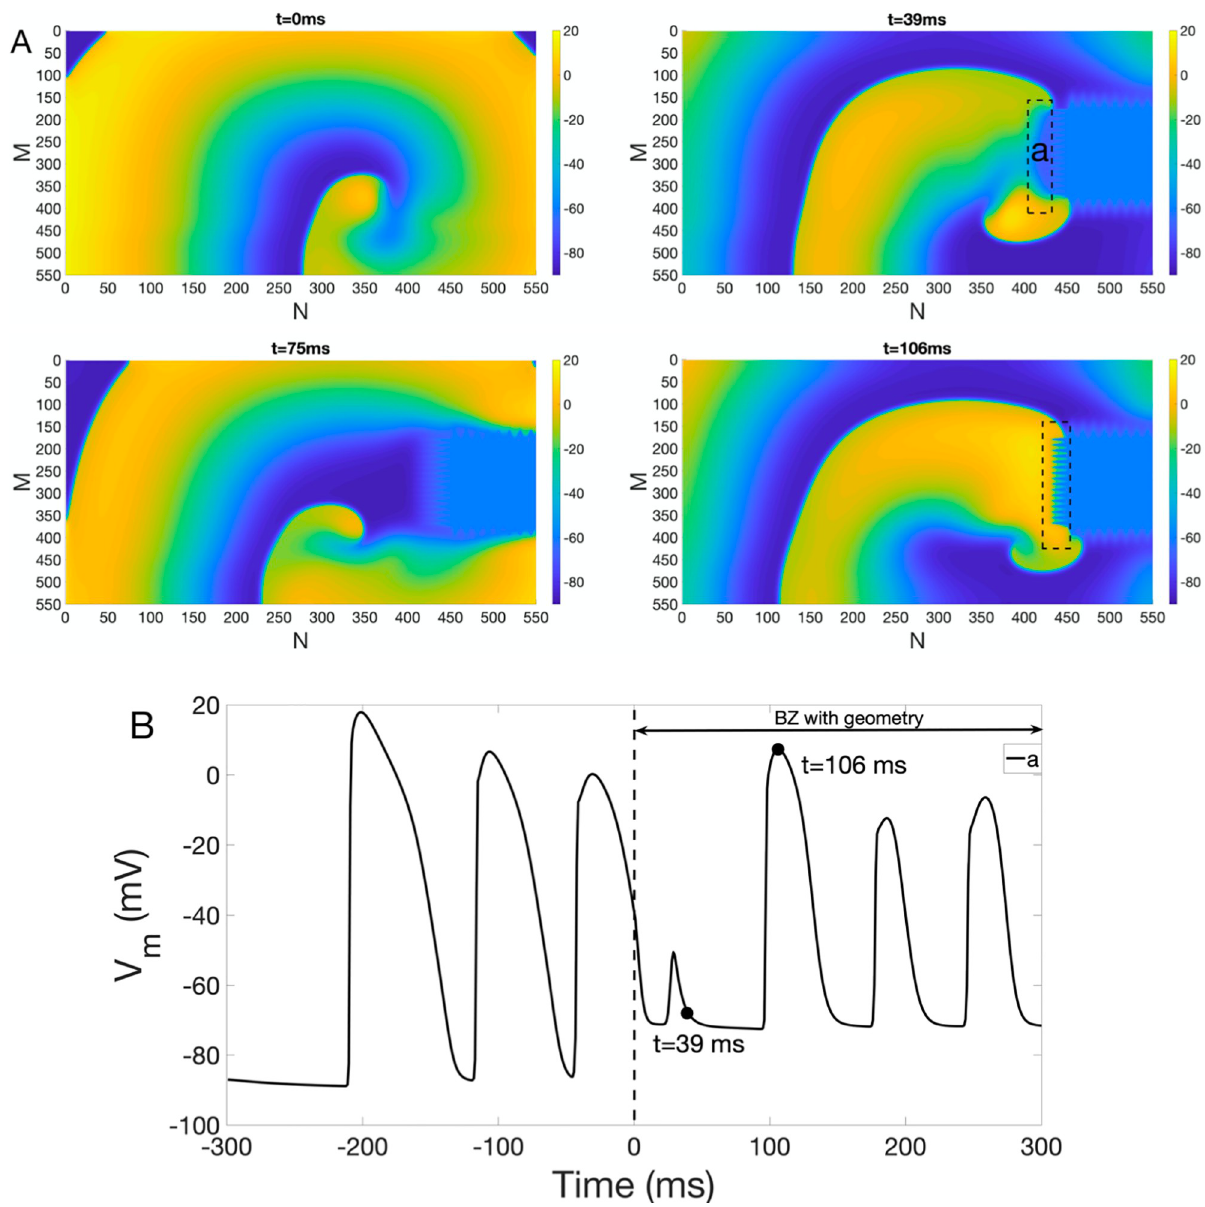
Fig 8. Spiral wavebreak and alternating CB under IC BZ with complex geometry (right). (A) Spiral wave break-up and alternating CB in the presence of BZ with complex geometry on the right. Colorbar indicates V ms are shown. Dashed black box indicates the place where wave break occurs. (B) V m traces at point a